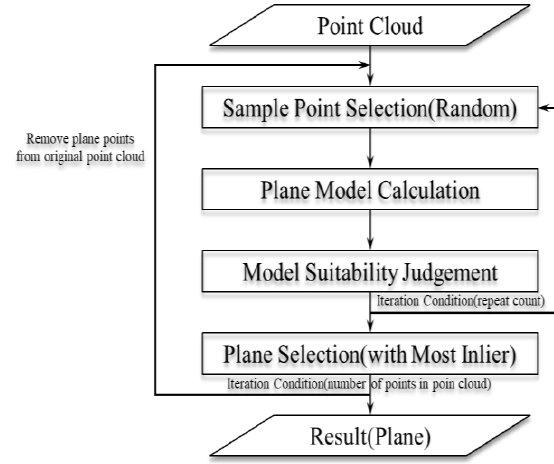
Figure 2. Process of ground plane removal.